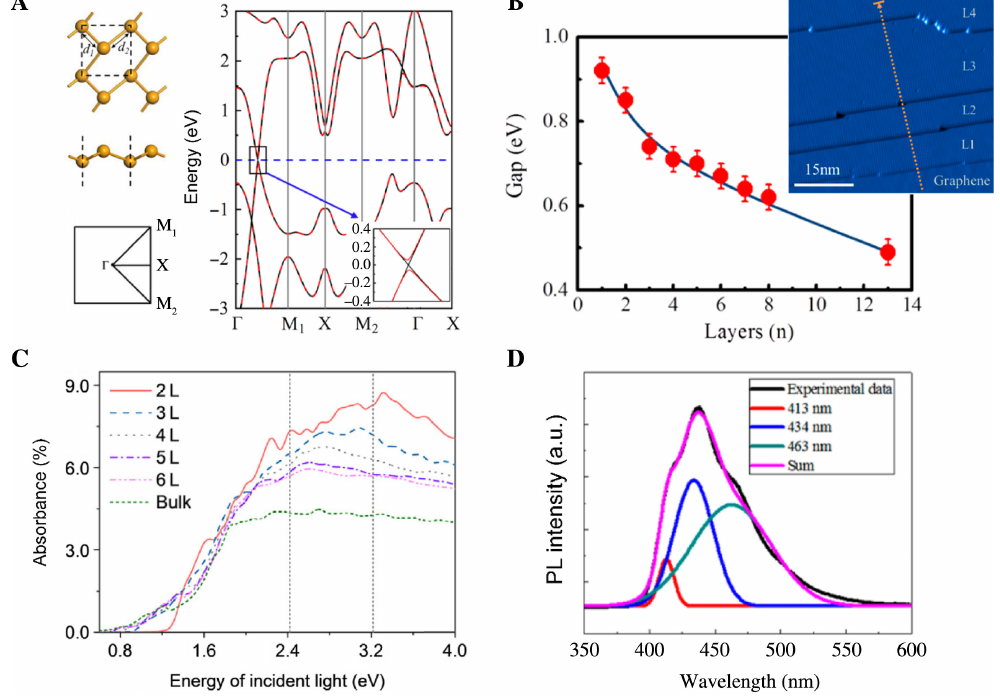
Figure 11: The band structure and optical performance of tellurene and selenene. (A) Top and side views of S -Se and its band structure with (red) and without (black) SOC effect. Inset is the zoom-in of the selected region Reproduced with permission [161]. Copyright 2014, IOP Publishing. (B) Layer-dependent bandgap of α -Te. Inset is the differential STM